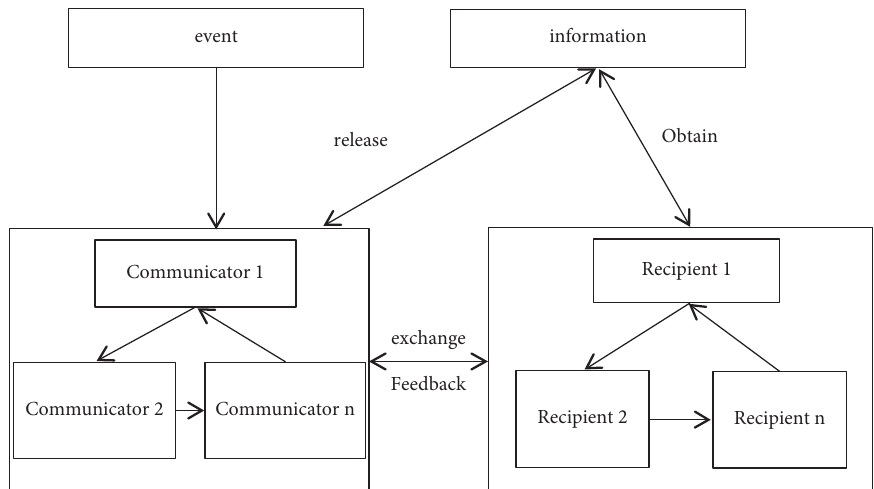
Figure 1: News dissemination